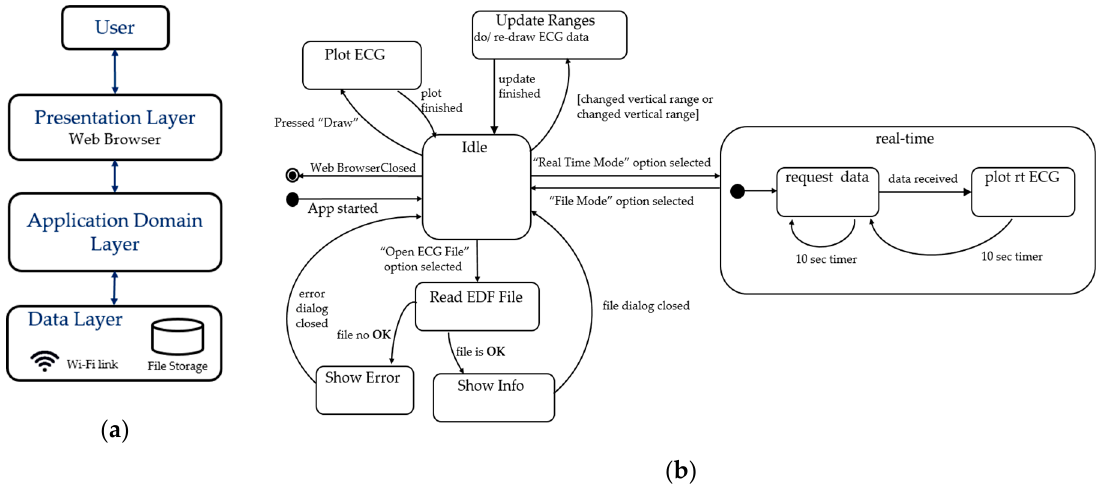
Figure 10. ECGView application approach: ( a ) three-layer architecture structure; ( b ) state diagram.